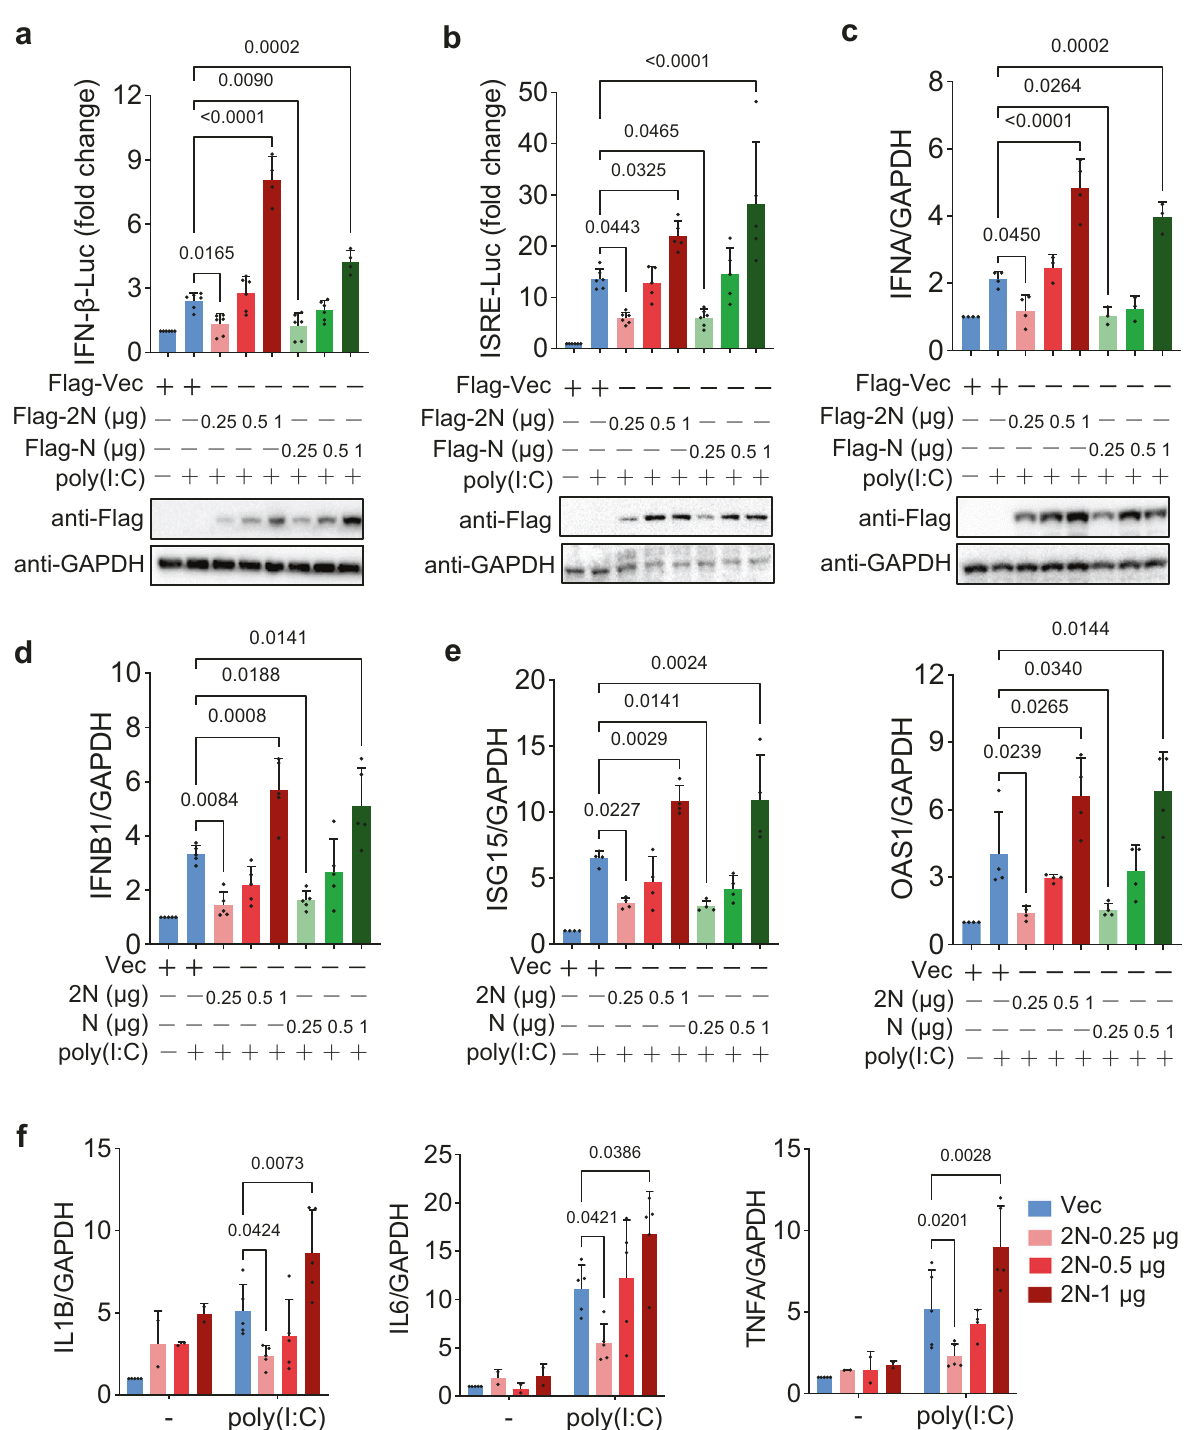
Fig. 1 N proteins dually regulate production of IFN-I and in fl ammatory cytokines. a , b HEK293T cells in 24-well plate were co-transfected with an IFN- β promoter ( a ) or ISRE reporter plasmid ( b ), along with control plasmid pGL4.74 and 0.25, 0.5, or 1 μ g SARS-CoV-2 or SARS-CoV N (2N or N) plasmids, then treated with or without poly(I:C), the empty vector as a control. At 24 h post-transfection (hpt), cells were harvested and luciferase activity was measured (upper); the expression of 2N and N proteins was detected by western blot, GAPDH as a loading control (down). c – e HEK293T cells in 24-well plate were transfected with 0.25, 0.5, or 1 μ g 2N or N plasmids, then treated with or without poly(I:C). At 24 hpt, the mRNA expression of IFNA ( c ), IFNB1 ( d ), and interferon-stimulated genes ISG15 and OAS1 ( e ) were examined using qPCR. f HEK293T cells in 24-well plate were transfected with a dose-gradient 2N plasmid, then treated with or without poly(I:C). At 24 hpt, the mRNA expression of IL1B , IL6 , and TNFA were examined using qPCR. Results shown are the mean ± SD of at least three independent